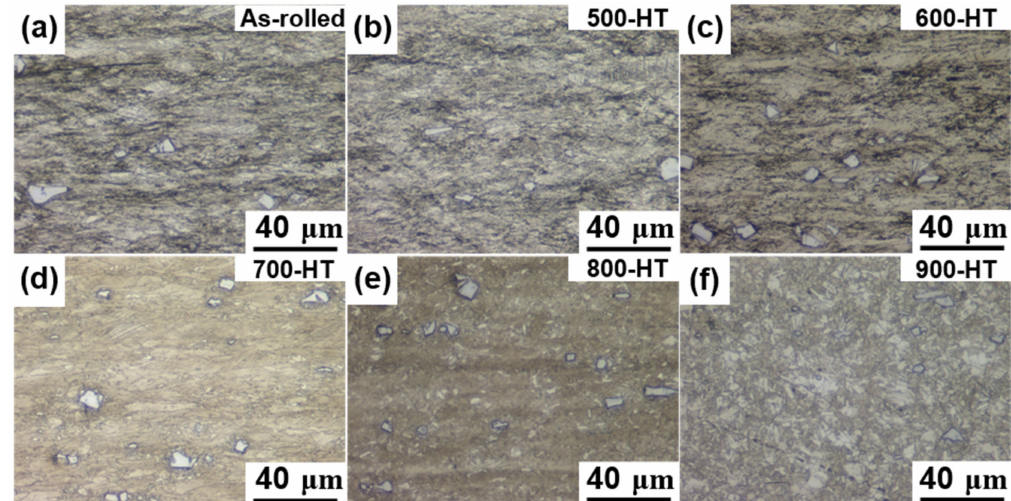
Figure 2. Optical microscope (OM) images ( × 500) of Fe-Mn-Si-based shape memory alloys (Fe-SMA) in different heat- treatment conditions. Rolling direction is horizontal to the images; ( a ) as-rolled, ( b ) 500 ◦ C heat-treated, ( c ) 600 ◦ C heat-treated, ( d ) 700 ◦ C heat-treated, ( e ) 800 ◦ C heat-treated, and ( f ) 900 ◦ C